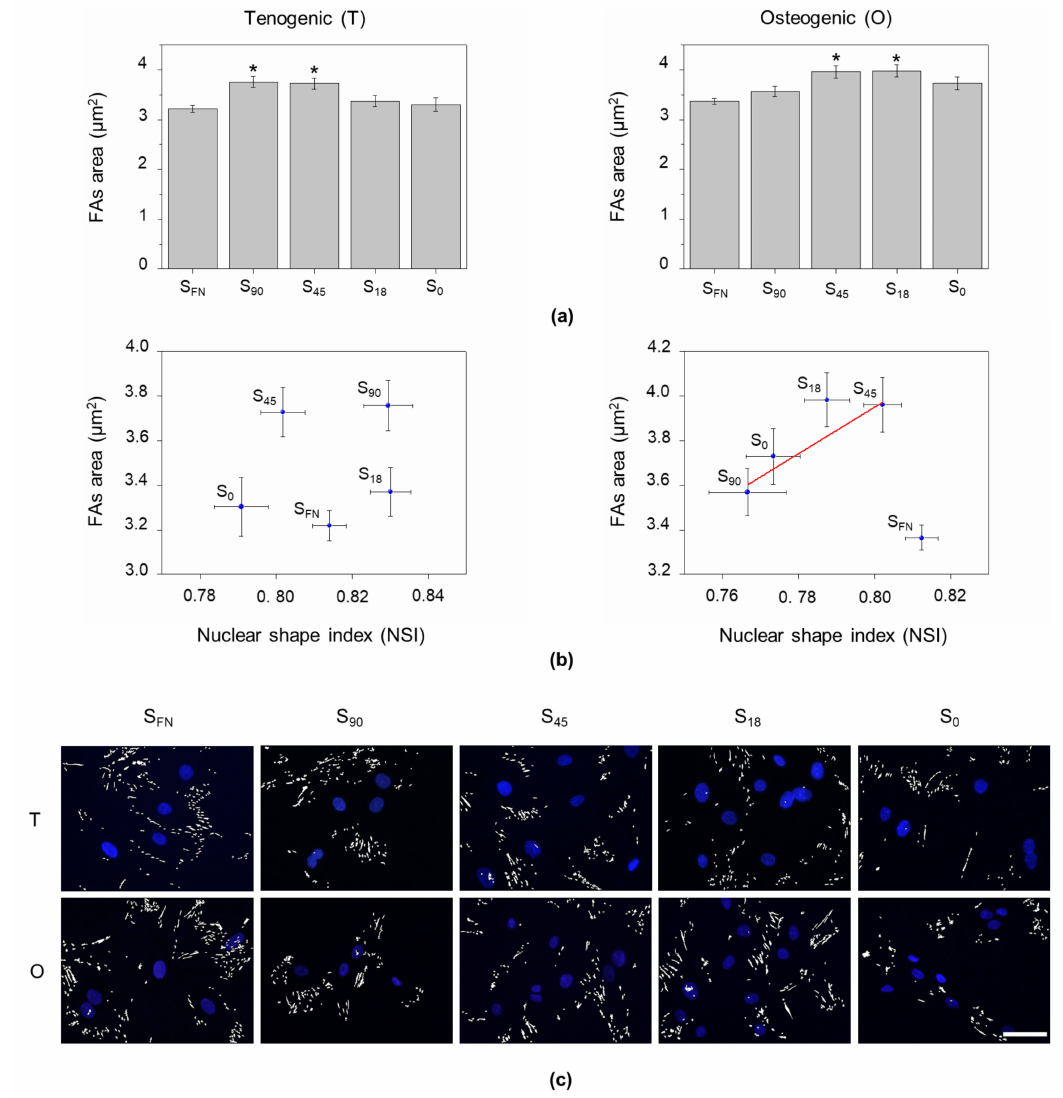
Figure 2. Focal adhesion (FA) size influence on nuclear distortion. ( a ) Representative epifluorescence images of hAMSCs after 24 h of culture under tenogenic (T) or osteogenic (O) induction, immunostained for the FA protein paxillin. ( a ) Quantification of FAs area as the average of paxillin-stained area per substrate in hAMSCs after 24 h of culture under tenogenic (T) or osteogenic (O) induction. ( b ) FAs area as a function of the NSI, showing it increases linearly (R = 0.9725) with the NSI only under osteogenic induction, excluding the positive control (S FN ). ( c ) Representative epifluorescence images showing the distribution of FAs (paxillin immunostaining) around the corresponding cell nuclei (Hoechst) under tenogenic (T) or osteogenic (O) induction after 24 h of culture. Data are given as the mean ± SE. Scale bar = 50 µ